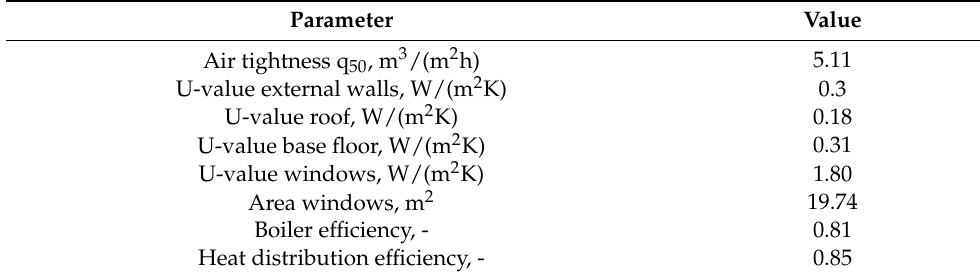
Table 2. The main technical details of the modified simulation